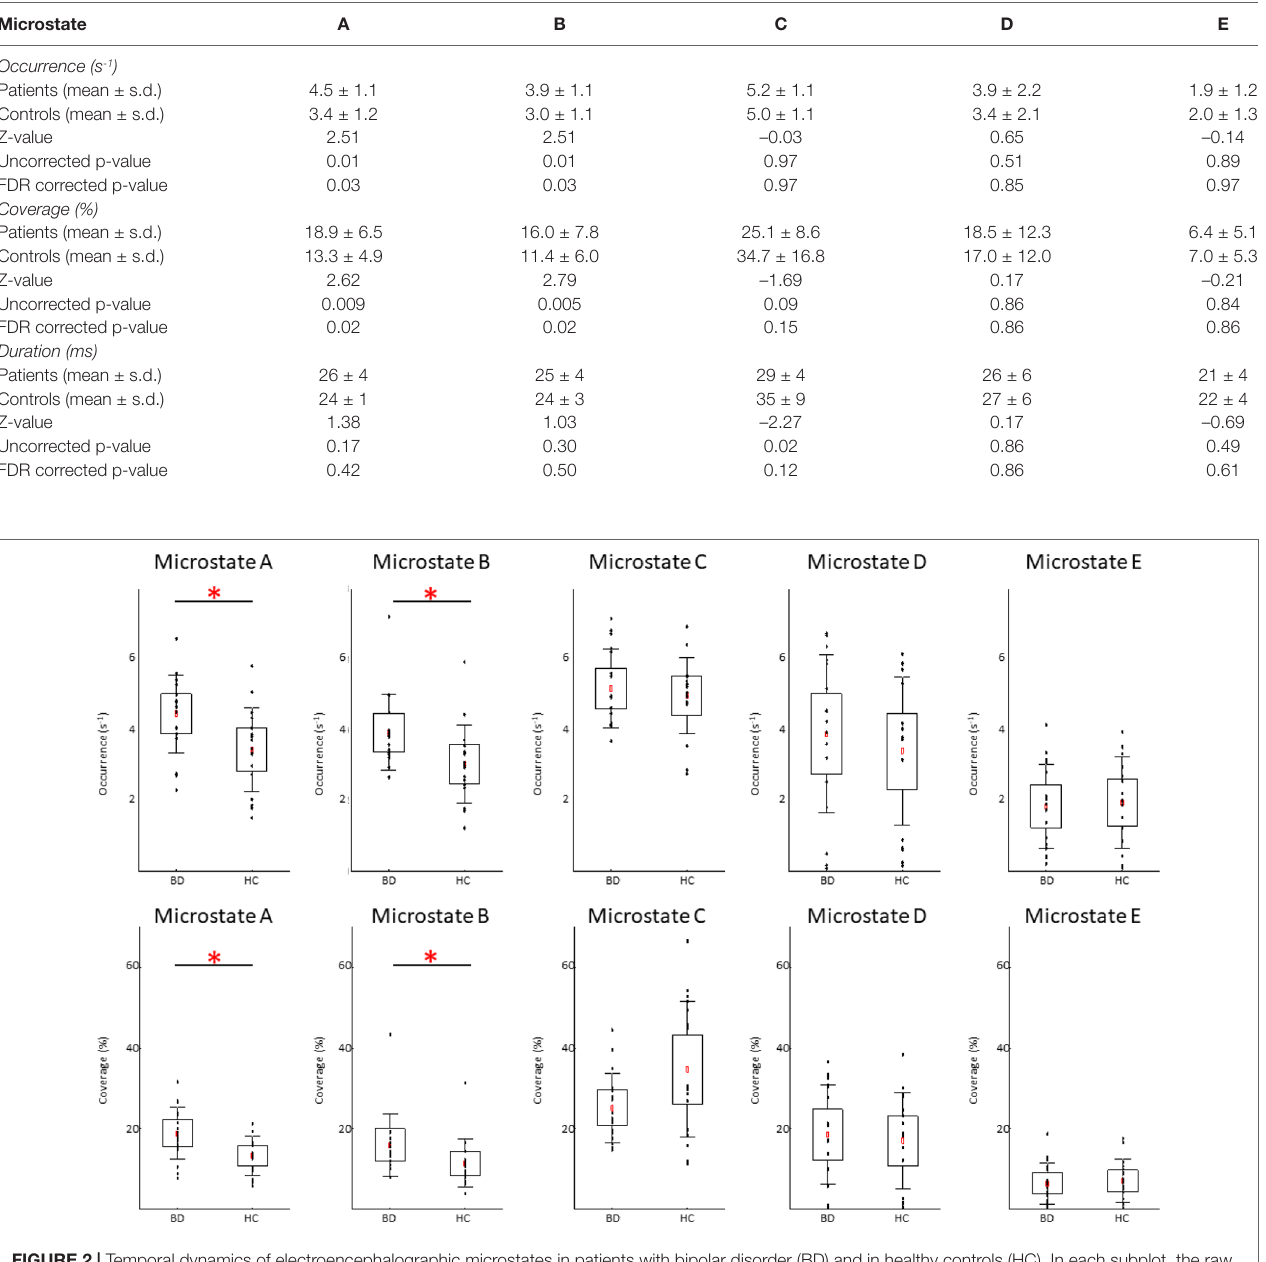
FIgURE 2 | Temporal dynamics of electroencephalographic microstates in patients with bipolar disorder (BD) and in healthy controls (HC). In each subplot, the raw data are plotted on top of the boxplot showing the mean ( ), 95% confidence interval (box plot area), 1 standard deviation (whiskers), and significant differences (*). In all plots, x-axes represent the subject group; y-axes represent the occurrence (upper plots) or coverage (lower plots). Note significantly increased occurrence and coverage of the microstate A and B in the BD compared to HC group (FDR corrected p < 0.05).